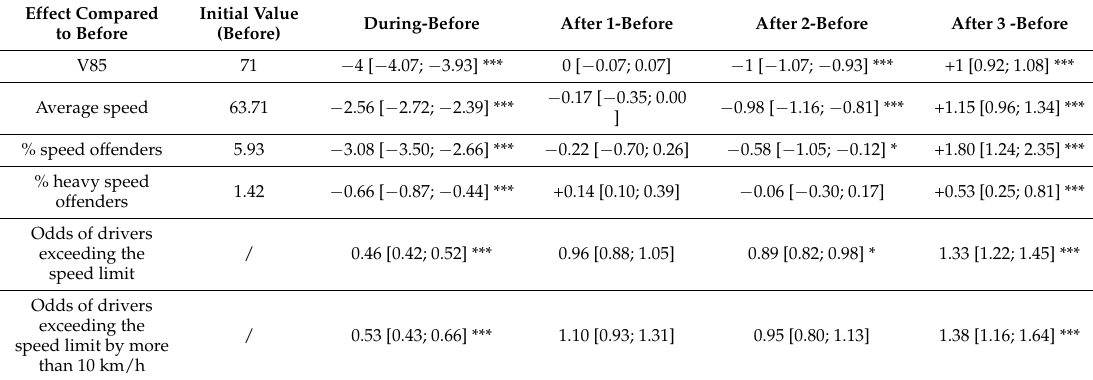
Table 6. Results of the overall effects at measurement point 2 in regional police unit 3.